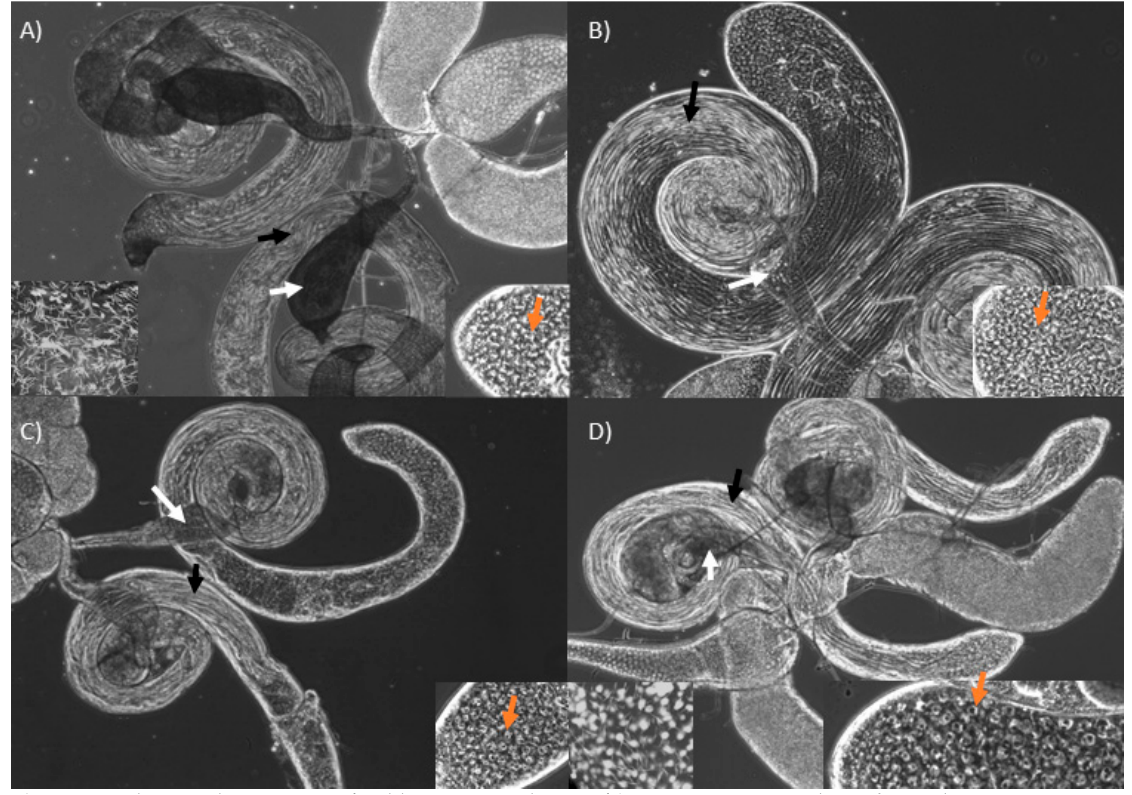
Figure 2. Male reproductive tract of wild-type ( A ) and KDs of bor ( B ), CSN5 ( C ) and Manf ( D ). Elongating cyst (black arrows) and seminal vesicles (white arrows) are shown. The seminal vesicle of KD males are small and lighter in color due to complete lack (B and C) or few mature sperm (D). The right bottom panels show presence of spermatocytes at the testes apical end (orange arrows). The left bottom panel (within A and D) show many and few mature sperm, seen as white needle-like structures, within a section of a wild-type and a Manf KD seminal vesicle, respectively.